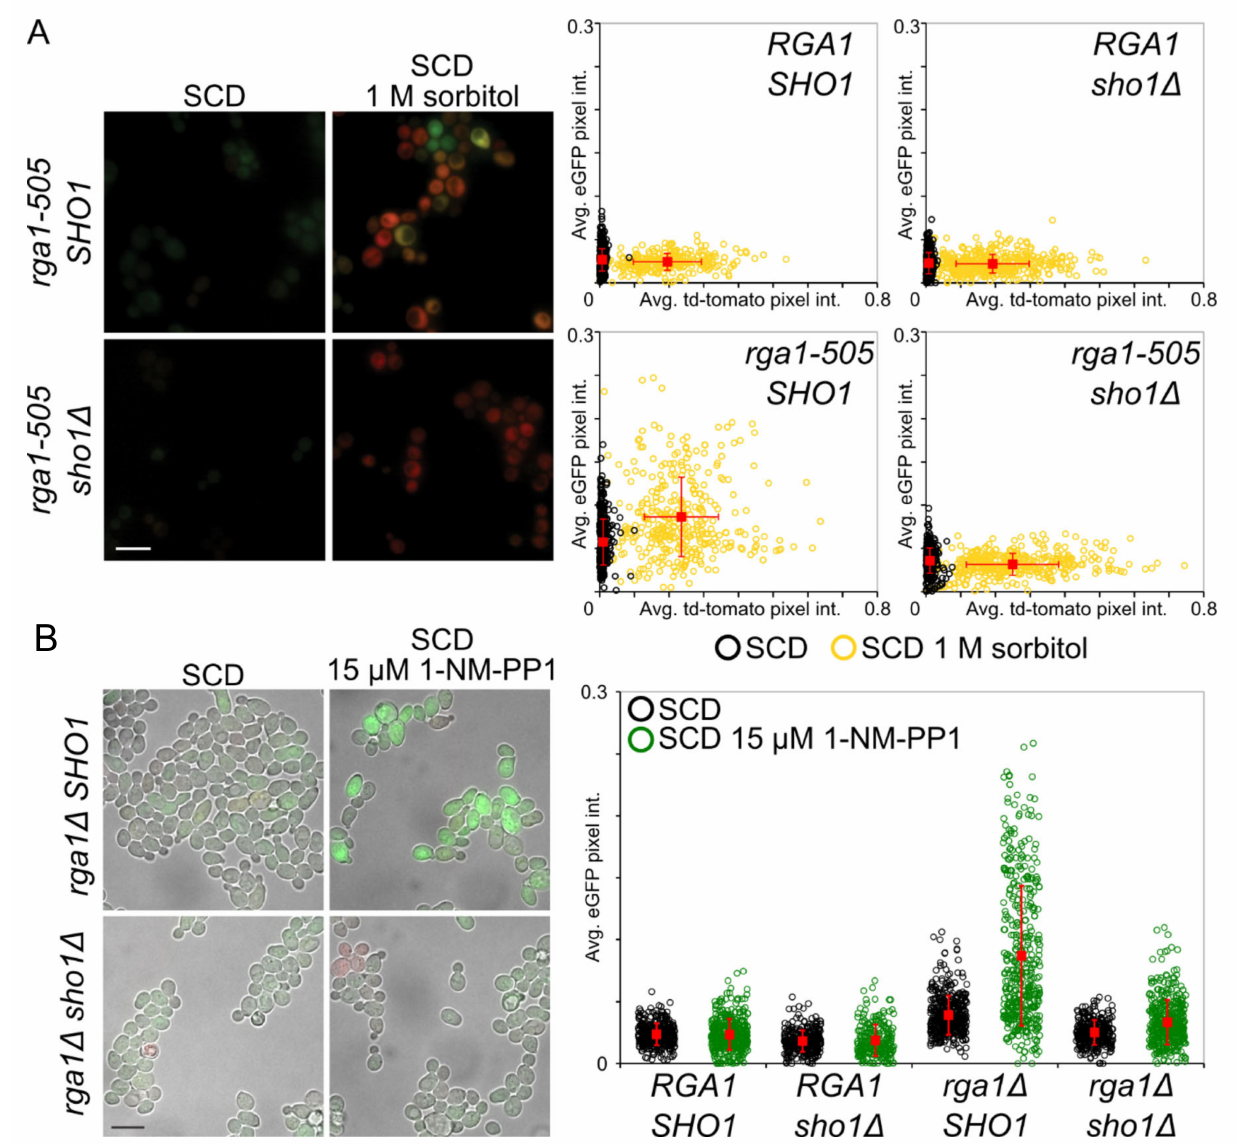
Figure 2. Cdc42-GAP Rga1 is required to squelch crosstalk elicited by hypertonic stress. ( A ) Strains RGA1 SHO1 (YJP213), RGA1 sho1 ∆ (YJP649), rga1-505 SHO1 (YJP610), and rga1-505 sho1 ∆ (YJP651) were grown to mid-exponential phase, and stimulated, as indicated, and analyzed by fluorescence microscopy. All four strains contain the HOG-pathway responsive reporter (which induces td-Tomato) and the mating-pathway responsive reporter (which induces eGFP). Quantification of HOG and mating pathway reporter expression (right panels). Each circle in the scatter plot represents the average eGFP (mating pathway reporter) and td-tomato (HOG pathway reporter) pixel intensity for a single cell in either the absence (black dots) or presence (yellow dots) of hyperosmotic stress; whisker plots (red) indicate the population mean and standard deviation. Representative micrographs (left panels) of the rga1-505 cells, with and without SHO1 , as indicated, under isotonic conditions (SCD) and after hyperosmotic shock (SCD + 1 M sorbitol). Scale bar (bottom left), 10 µ m. ( B ) Cdc42-GAP Rga1 is required to squelch crosstalk elicited by Hog1 inhibition. Strains RGA1 SHO1 (YJP213), RGA1 sho1 ∆ (YJP649), rga1 ∆ SHO1 (YJP552), and rga1 ∆ sho1 ∆ (YJP650), all containing HOG1-AS , were grown to mid-exponential phase, and then subjected for vehicle only control or 15 µ M 1-NM-PP1. Quantification of mating pathway reporter expression only was performed as in (A) (right panels). Representative micrographs of the rga1 ∆ SHO1 and rga1 ∆ sho1 ∆ cells (left panels. Scale bar (bottom left), 10 µ